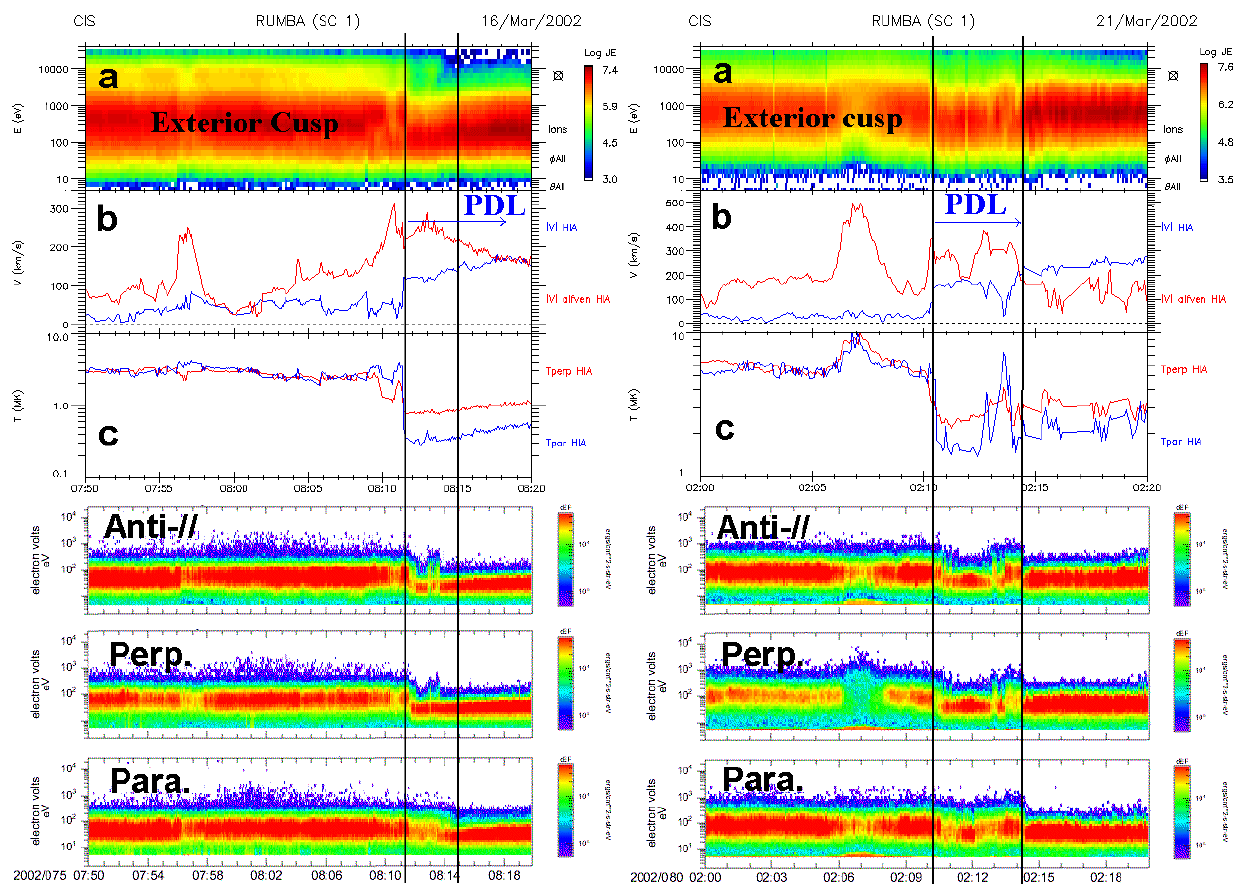
Figure 9. Plates showing a zoom of the combined Cluster CIS, FGM and PEACE data, focused on the exterior cusp-magnetosheath boundary for two events: 16/03/2002 and 21/03/2002. Panels a show the spectrograms from HIA. Panels b show the magnitude of the HIA ion velocity together with the Alfvén speed (from FGM magnetic data). The ion temperature (parallel and perpendicular) is displayed in panels c. Following are the electron spectrograms for the anti-parallel, perpendicular and parallel flowing electrons from the PEACE instrument for the same interval. The extents of the plasma depletion layer (PDL; shown by the blue arrow) and of the magnetosheath, heated electron boundary layer (between the two vertical black lines) are highlighted.